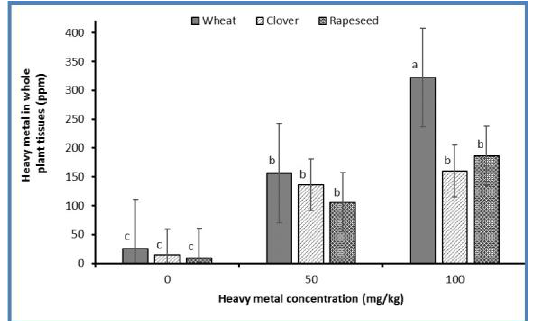
Figure 2. The interaction of plant type and element concentration in soil on the uptake of heavy